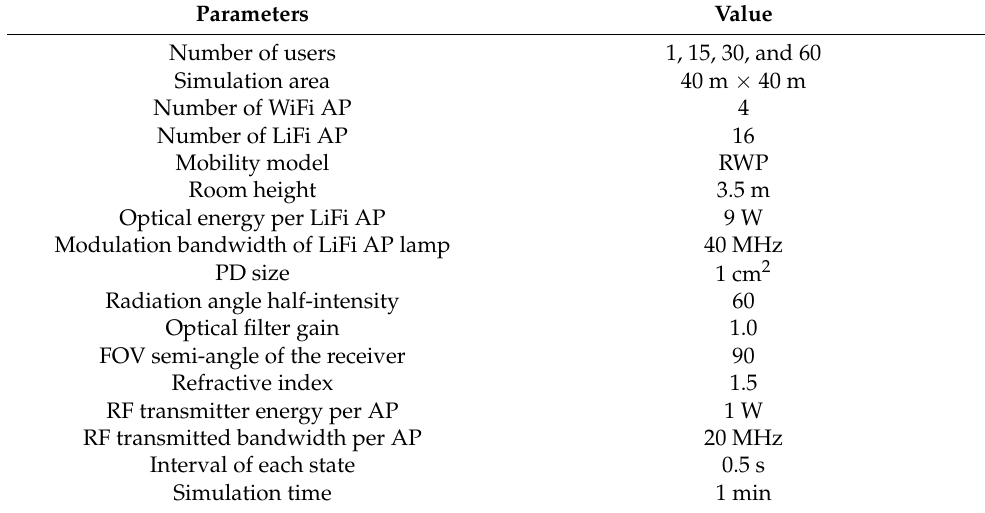
Table 4. Simulation Parameters. Parameters Value Number of users 1, 15, 30, and